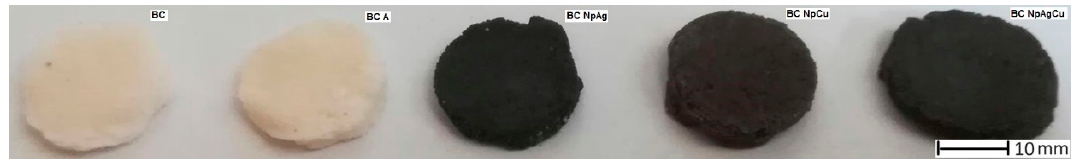
Figure 1. Sample specimens used in the research.